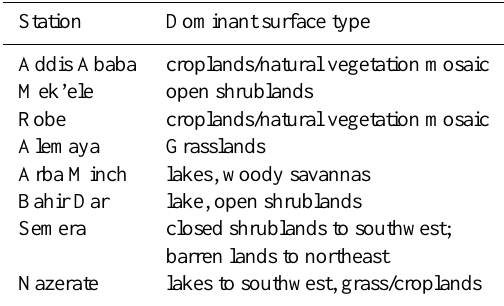
Table 6. Dominant surface types within 50 km radius of the eight GPS stations obtained from MODIS 0.5 × 0.5km resolution data (Broxton et al.,